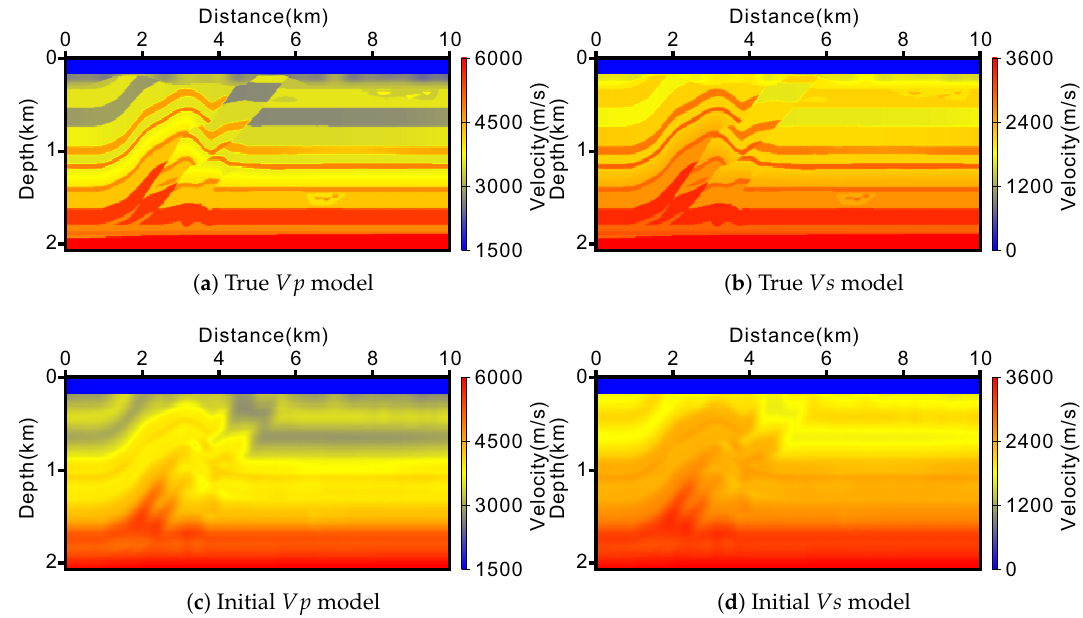
Figure 4. True and initial parameters of the Overthrust model: ( a , c ) Vp and ( b , d ) Vs .